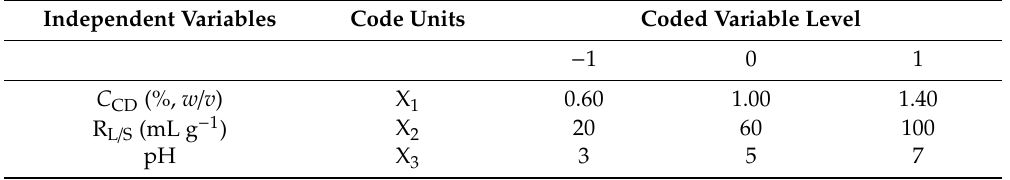
Table 1. Process variables (actual and coded levels) considered for the design of